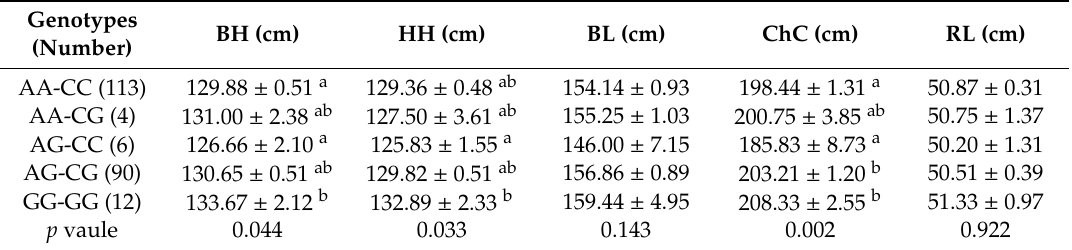
Table 6. Association analysis of combined genotypes in RET with body measurement traits in Qinchuan